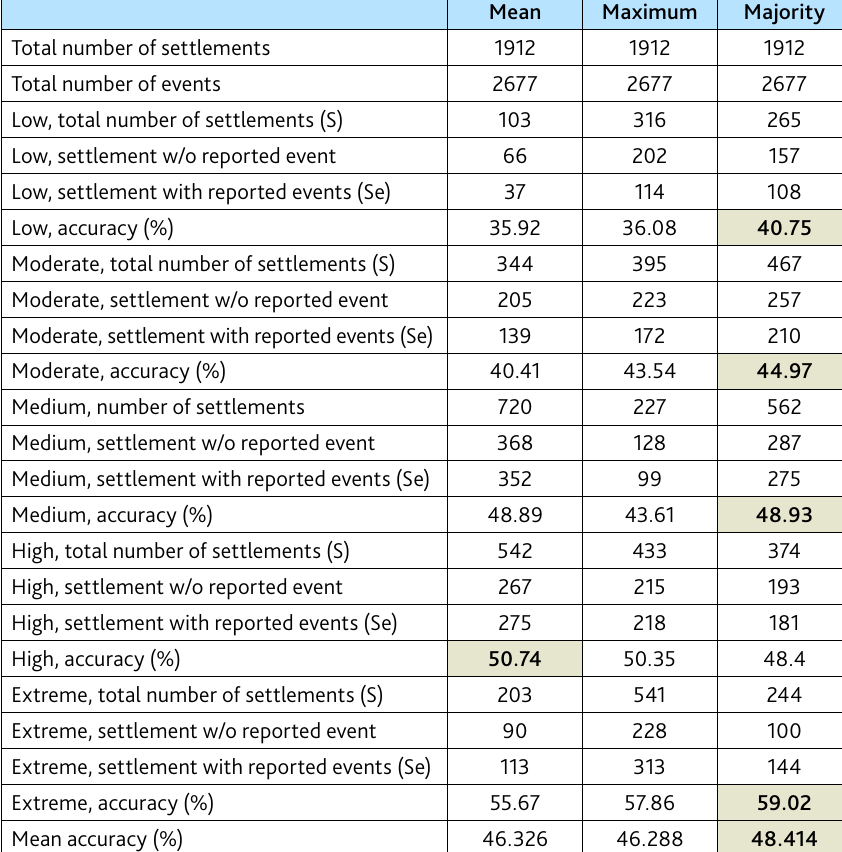
Table 4. Verification statistics for the FFSIs